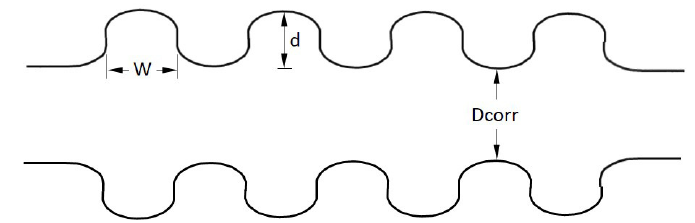
Figure 3. Corrugated pipe geometry (not to scale). Table 1. Various combinations of smooth and corrugated pipes categorized into two cases. Case a refers to the three different L corr values (250, 350, and 450 mm) for one L up value (100 mm) and four L dw values (100, 200, 300 and 400 mm). Case b corresponds to the same three L corr values for one L dw value (100 mm) and four L up values (100, 200, 300 and 400